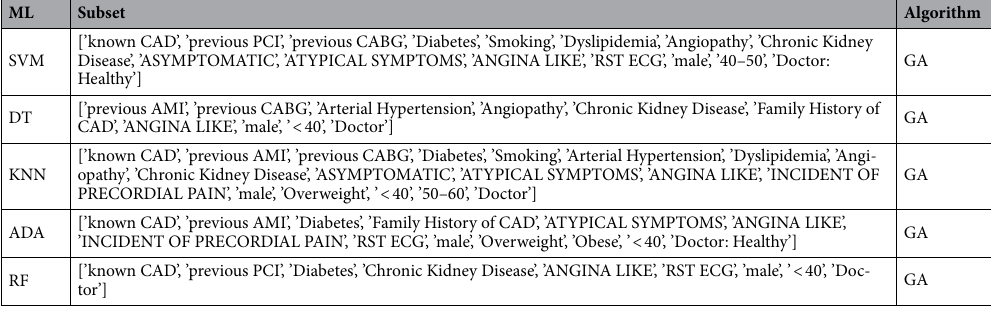
Table 6. Best performing feature subsets for each ML model and their selection algorithm (with expert verdict).